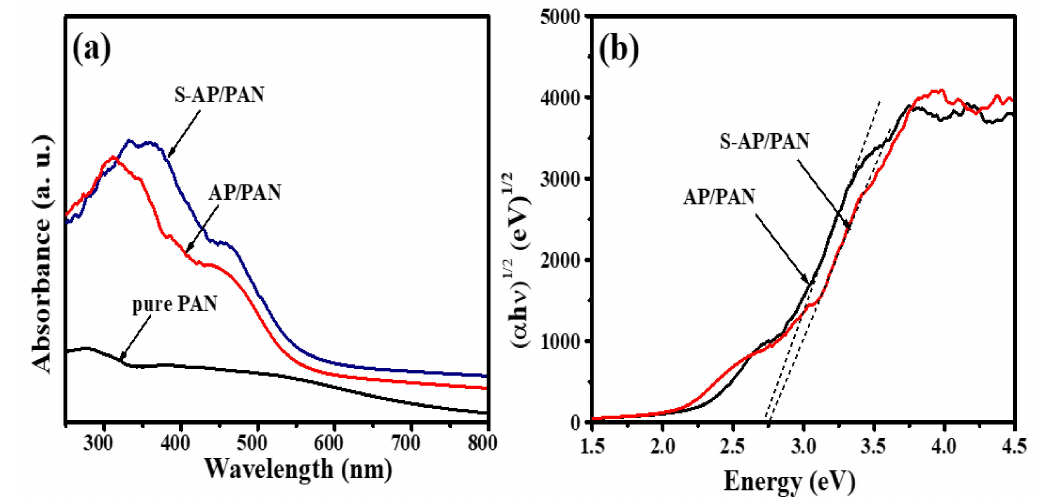
Figure 5. UV-vis di ff usive reflectance spectra ( a ) and plot of ( α h ν ) 1 / 2 versus energy (h ν ) of as prepared photocatalysts ( b